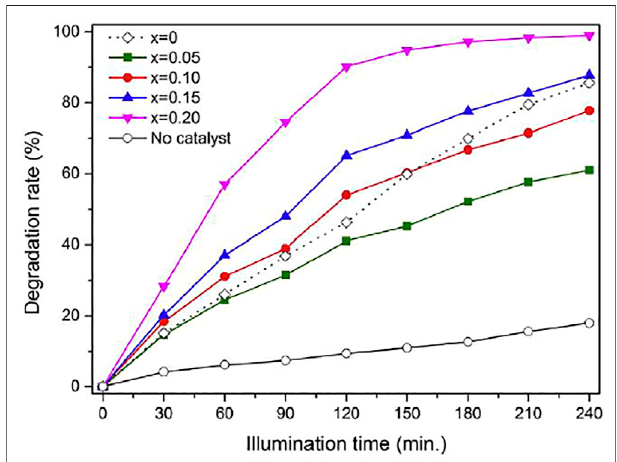
FIGURE 3 | Degradation rate curve with x value of Mg 1-x Zn x Al 2 O 4 spinel nanoparticles (Li et al., 2016). Adapted from ref. (Li et al., 2016). Copyright © 2016 Elsevier Masson SAS.